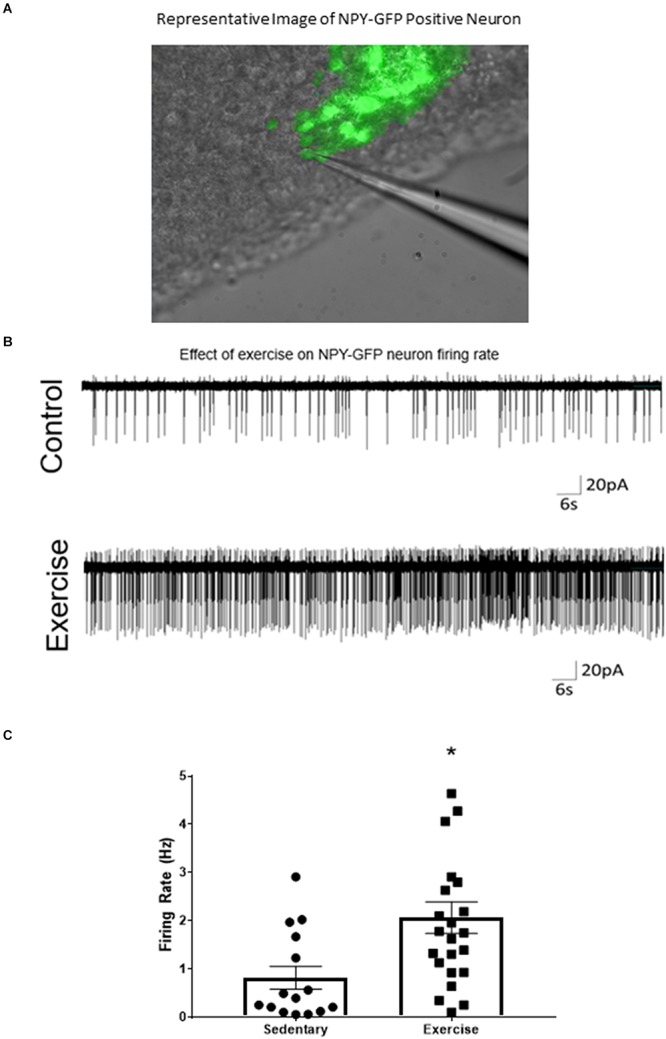
ARCAgRP/NPY neuron firing rate ex vivo is increased after an acute bout of exercise. (A) Representative image of patch-clamp pipette sealed to NPY-GFP neuron in the ARC. (B) Representative cell attached trace of ARCAgRP/NPY neuron firing rate in voltage clamp (–50 mV) after sedentary and exercise conditions. (C) Calculated firing rate of ARCAgRP/NPY neurons in mice. Data are expressed as mean ± SEM. (N = 15–22 neurons from 8 mice (4 male and 4 female) per group) * indicates p < 0.05 vs. sedentary group.